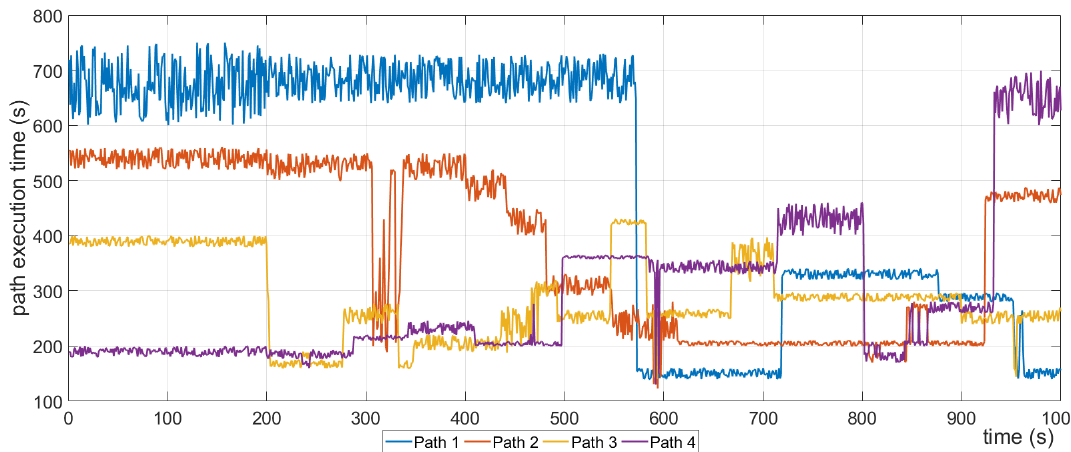
Figure 23. Total execution time per